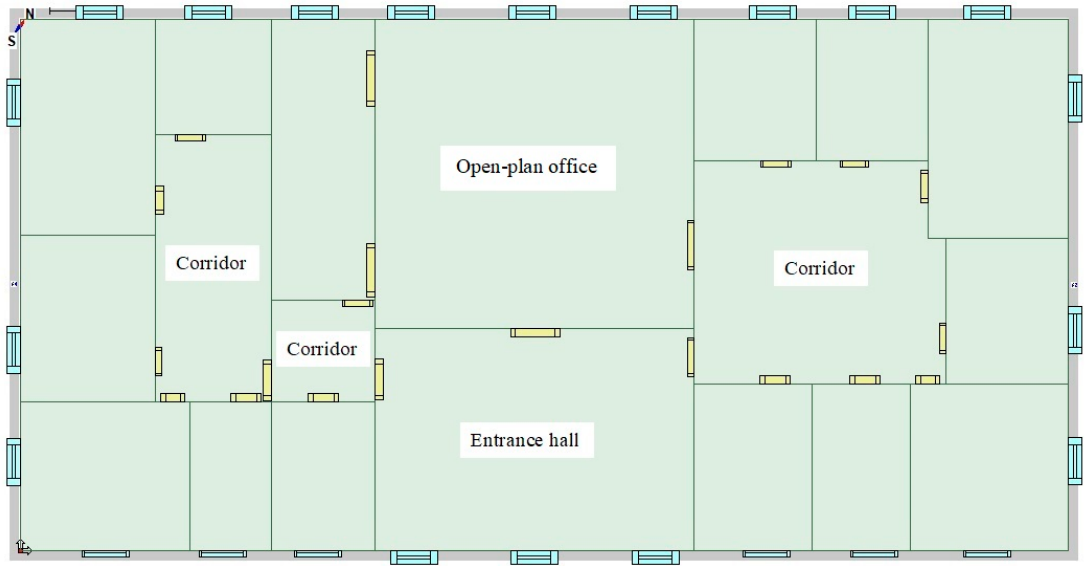
Figure 5. The model of the representative floor level (unlabeled zones are offices).